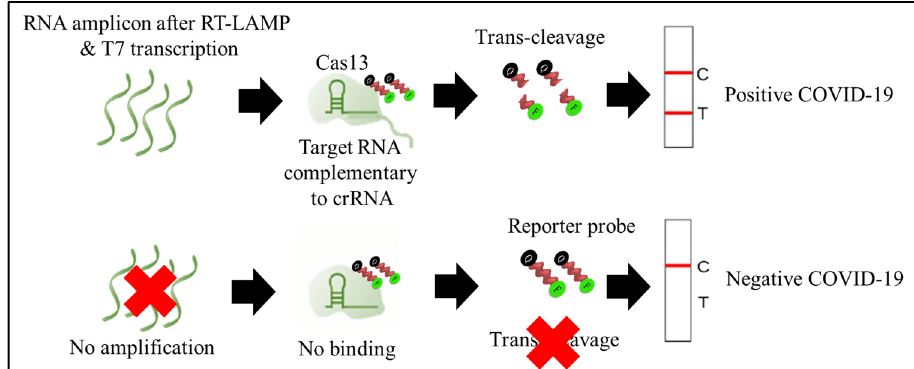
Figure 5. Schematic diagram depicted the trans-cleavage activity of Cas13 enzyme. In the presence of SAR-CoV-2 virus, the RNA amplicon after RT-LAMP and T7 transcription was complemented to pre-designed crRNA (ribonucleoprotein complex, Cas13 + crRNA + amplicon). As a result, the Cas13 enzyme was activated to cleave the reporter probes, and the lateral flow assay (IFA) showed both a control (C) and a test (T) line, indicating a positive COVID-19 result. In absence of SAR-CoV-2 virus, there was no amplification of target site and binding to crRNA. Thus, Cas13 enzyme remain inactivated, and the reporter probes were not cleaved. The LFA showed only control line, indicating negative COVID-19 result. The un-cleaved reporter molecules are captured at the first detection line (control line), whereas indiscriminate Cas13 cleavage activity generates a signal at the second detection line (test line).